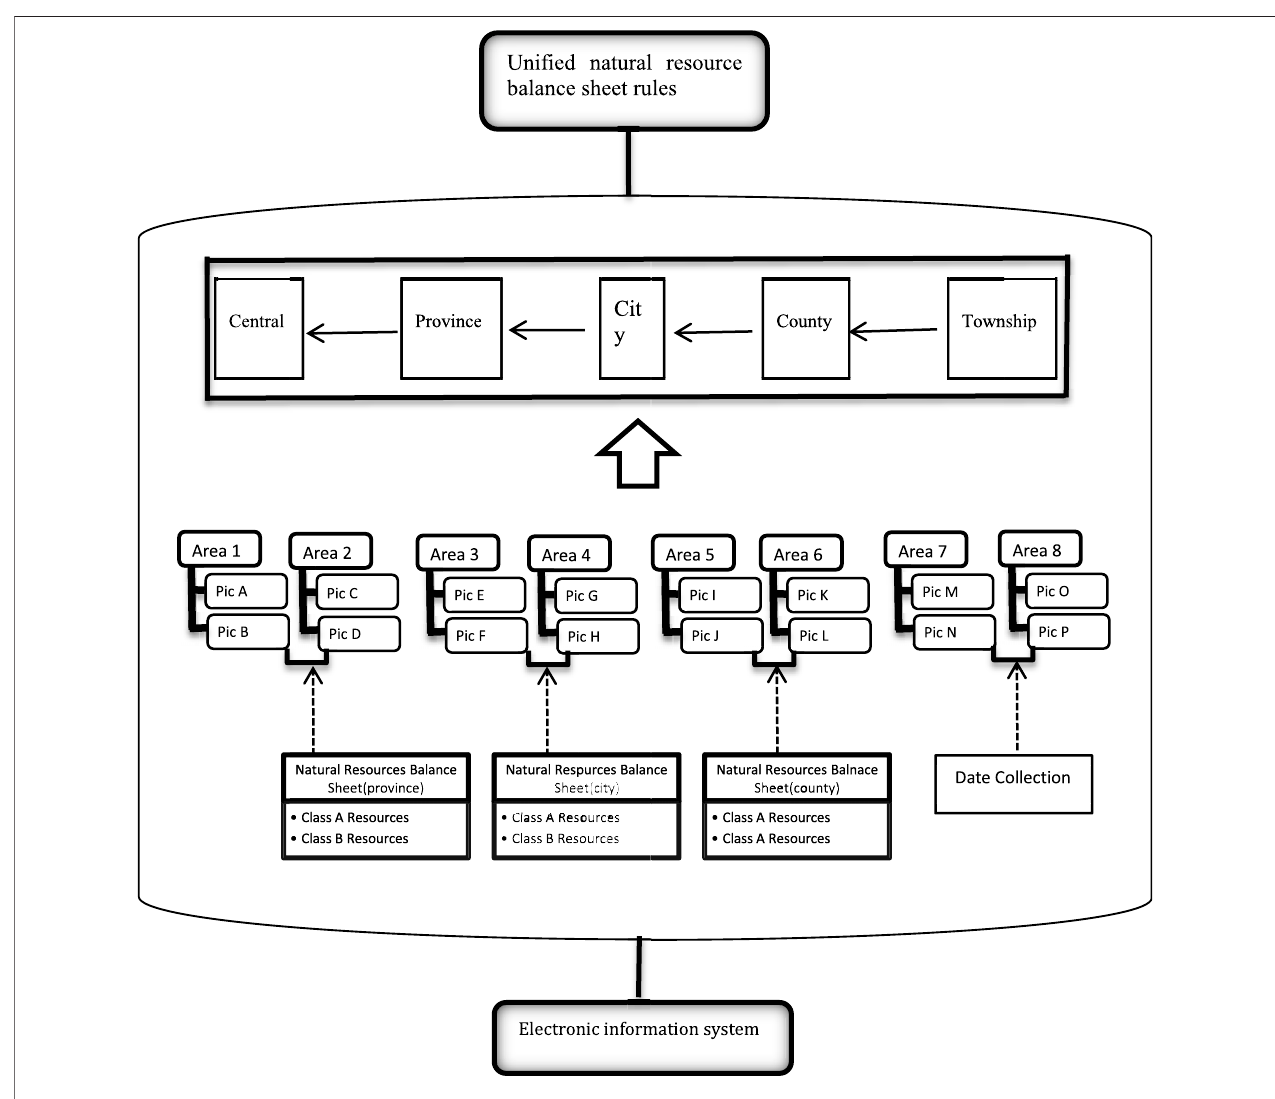
FIGURE 1 | Data acquisition path of natural resources balance sheet